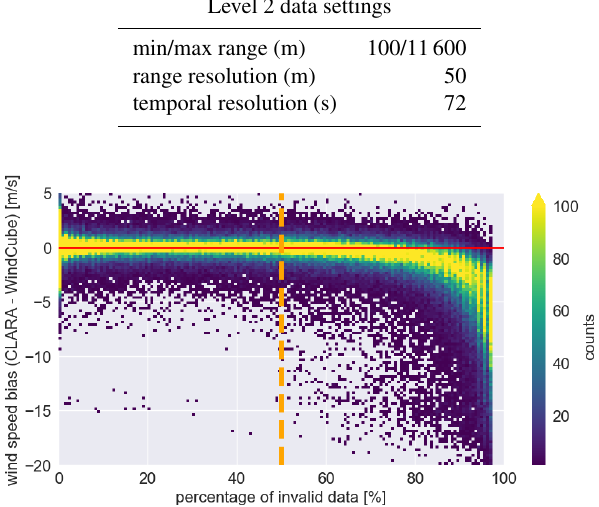
Figure 3. Two-dimensional histogram of the differences between the wind speed retrieved from CLARA’s and WindCube’s obser- vations as a function of the invalid index; the horizontal red line indicates 0ms − 1 and the vertical dashed orange line indicates the invalid index value of